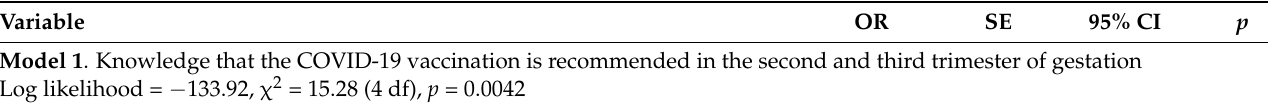
Table 2. Results of the multivariate logistic and linear regression analysis showing determinants of the different outcomes of